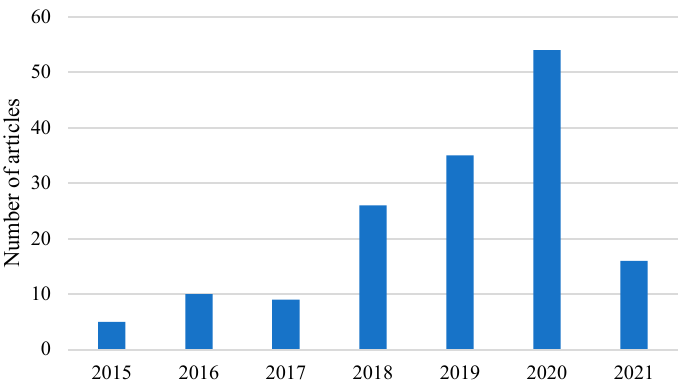
Figure 2. Number of articles published in the last six years regarding the extraction of phenolic compounds such as phenolic acids and flavonoids. (Data on Scopus using keywords “deep eutectic solvents phenolic extraction”, accessed on 18 March 2021.)